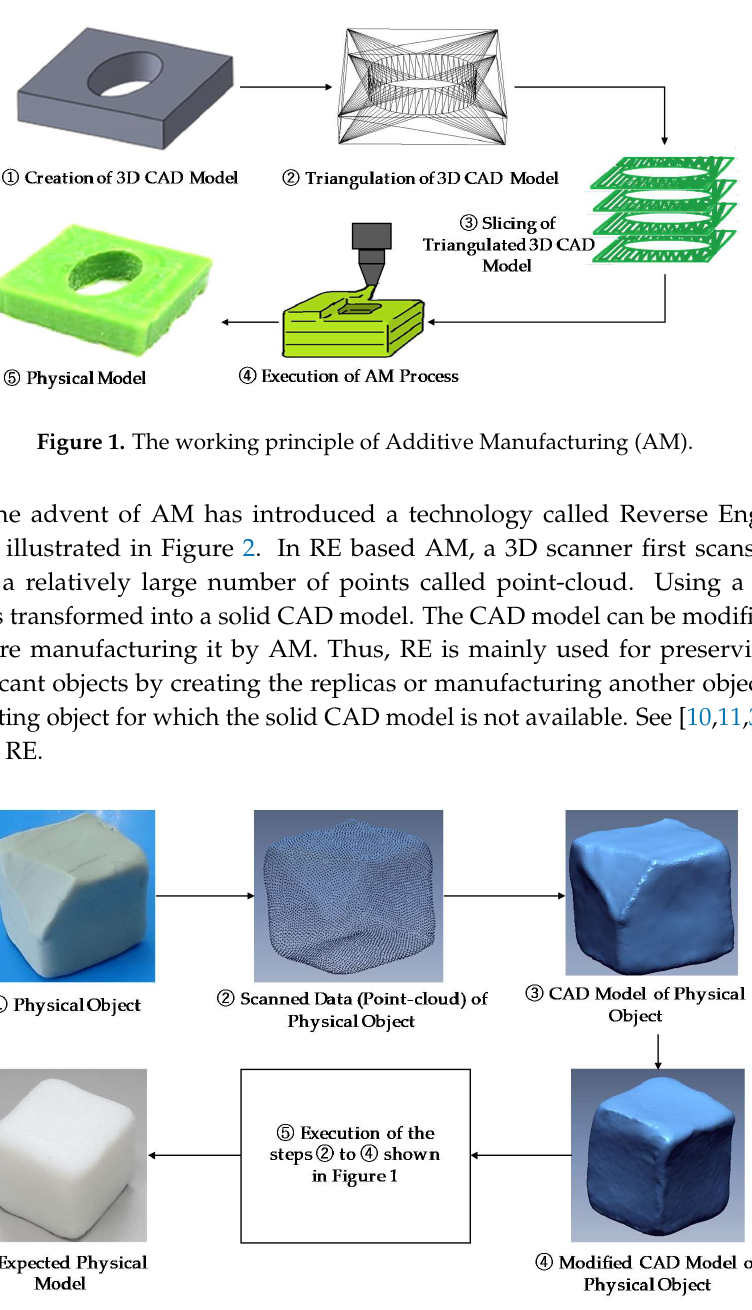
Figure 2. A workflow for Reverse Engineering (RE) based AM.